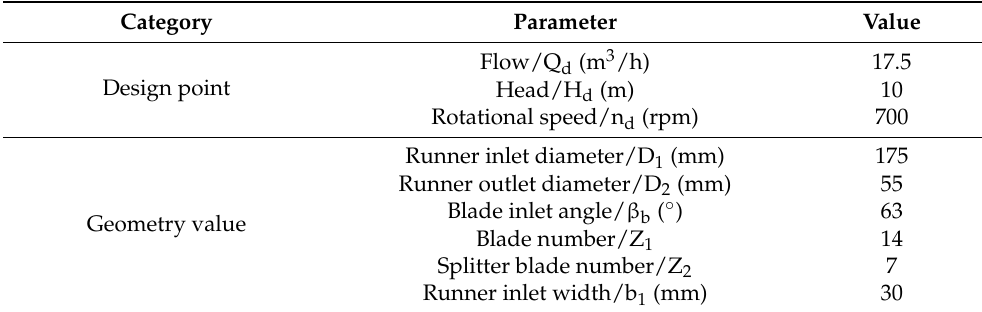
Figure 1. Geometry of the impulse water turbine. ( 1 ) draft tube; ( 2 ) turbine casing; ( 3 ) nozzle; ( 4 ) open runner. Table 1. Specifications of the impulse water turbine.